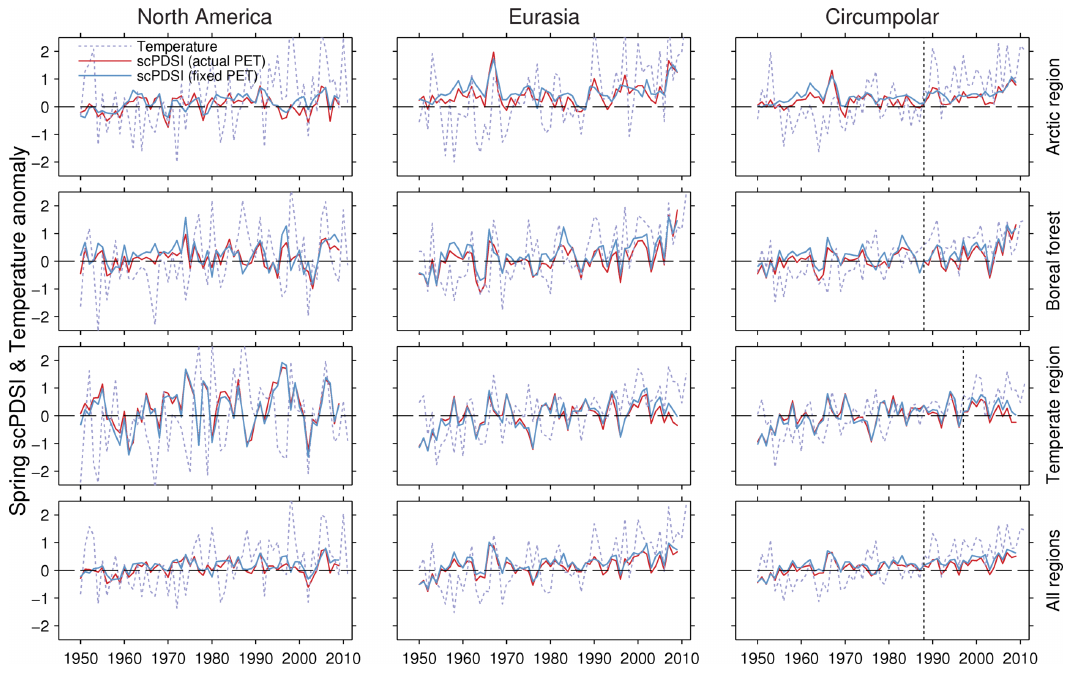
Figure A3. Comparisons of late-spring (April–May) scPDSI averages with (red) and without (blue) changes in potential evapotranspiration and snowmelt by region and continent. Mean April–May temperature anomalies relative to the period 1961–1990 (dotted line) are shown for each region. The vertical dotted lines denote the years 1988 or 1997.